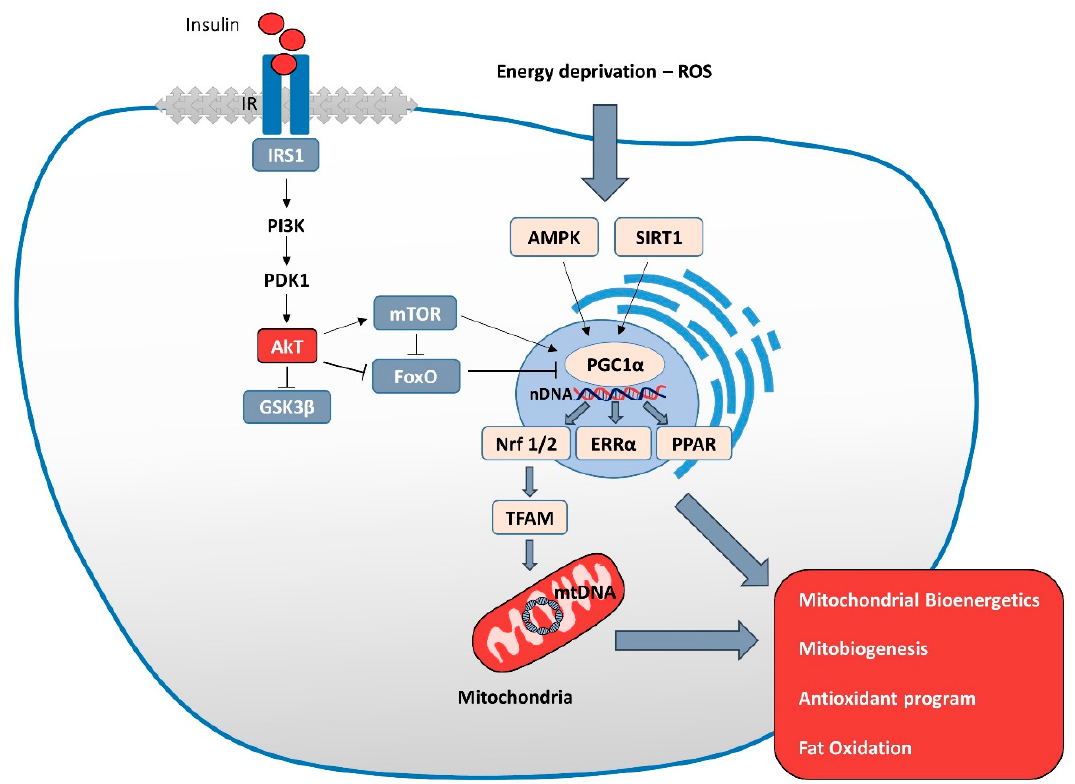
Figure 2. Schematic representation of PGC-1 α -driven biogenesis and mitochondrial regulation and its interactions with some of its target transcription factors involved in metabolic regulation in response to nutrient availability or energy demand. The detailed action of each regulatory path is discussed in the text.